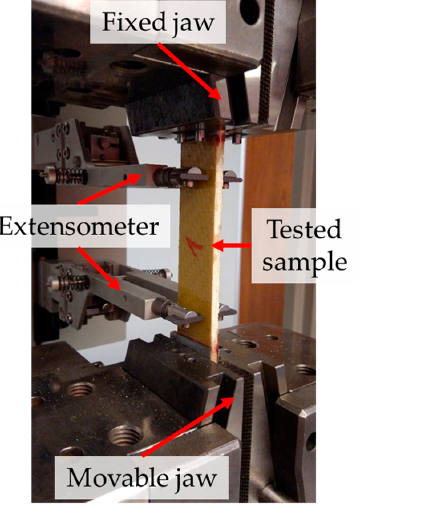
Figure 10. Tensile test of a composite sample reinforced by Twaron 2200 fibers: ( a ) sample (with active extensometer) placed in the jaws, ( b ) sample after rupture.